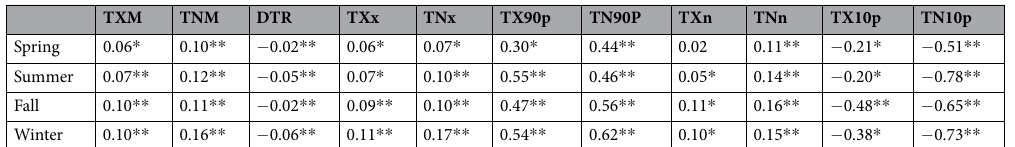
Table 1. Seasonal trends in average monthly indices from 1960–2014. For description of index names, see Supplementary Table S1. TXM: daily mean maximum temperature, TNM: daily mean minimum temperature. For description of index names, see Supplementary Information S2. * and ** denote significance at the 0.05 and 0.01 level,